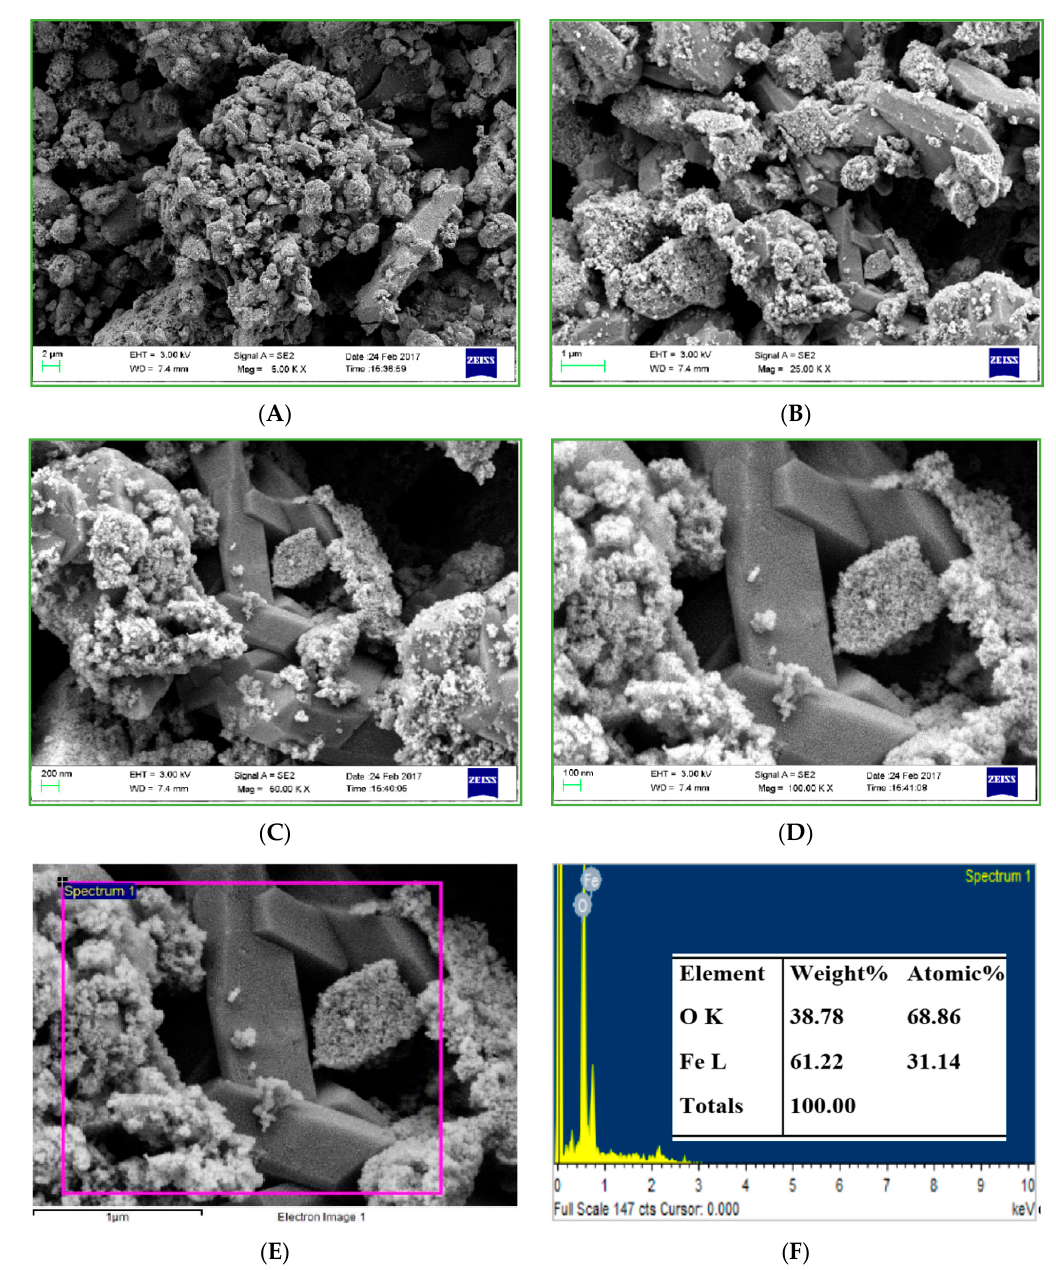
Figure 6. Field-emission scanning electron microscopy (FESEM) images of IONPs ( A – D ), electron di ff raction spectroscopy (EDS) spot ( E ) and EDS spectra ( F